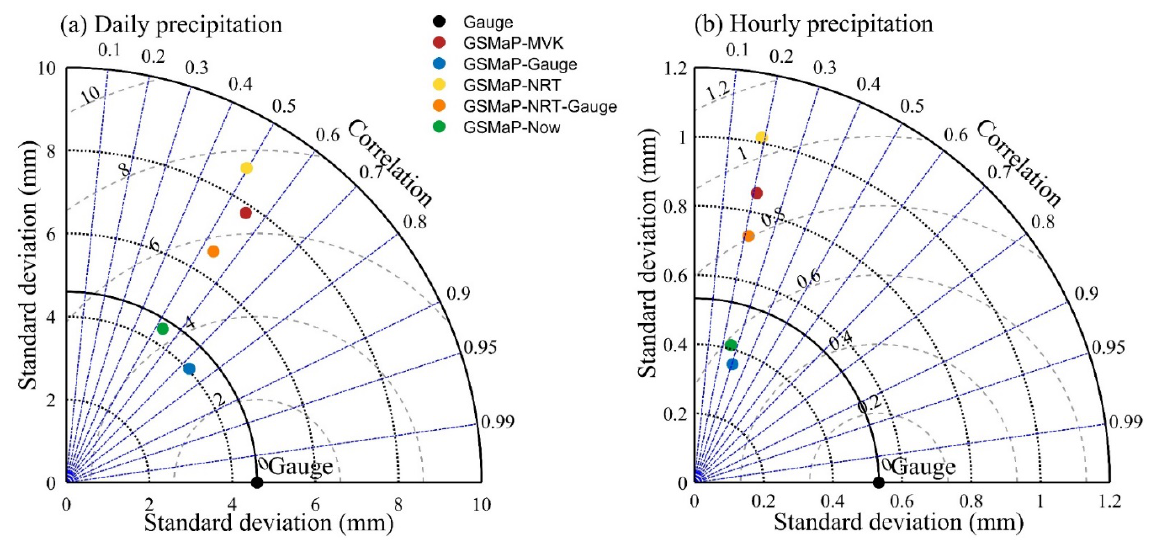
Figure 5. Taylor diagrams for comparing the five GSMaP SPPs at the locations of the 13 weather stations in YRSR with respect to the gauge observations (29 March 2017–31 December 2018): ( a ) daily precipitation estimates and ( b ) hourly precipitation estimates.